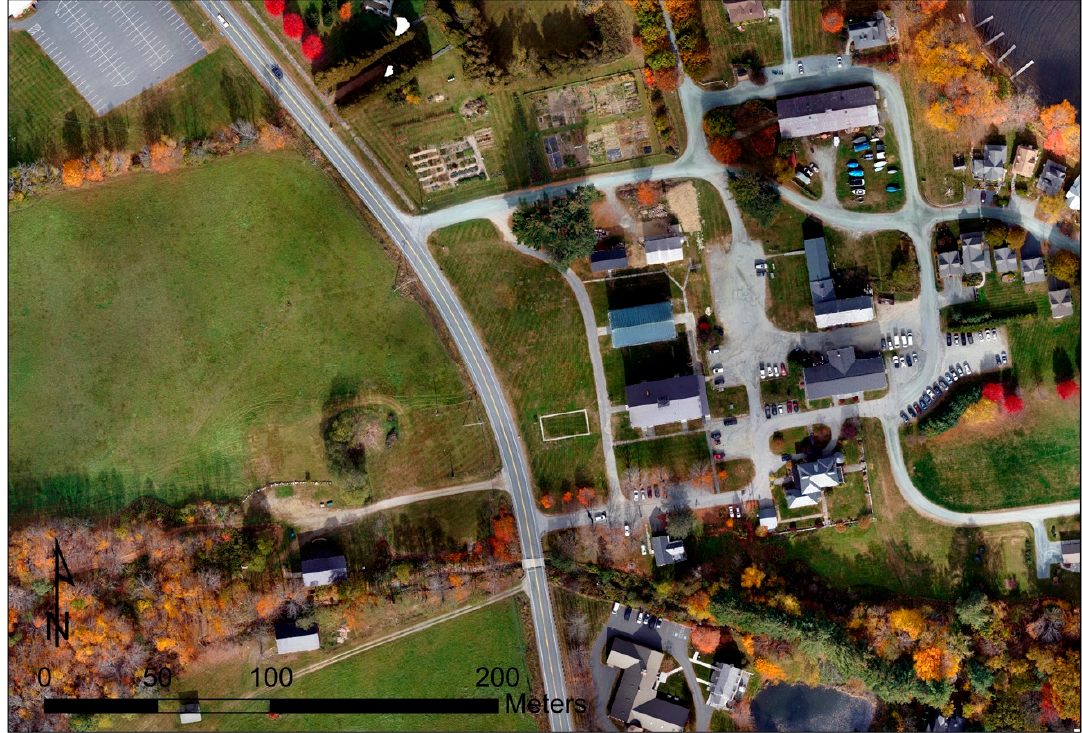
Figure 2. Detailed orthophoto of the Enfield Shaker Village derived from fixed wing drone photography recorded on 23 October 2017.